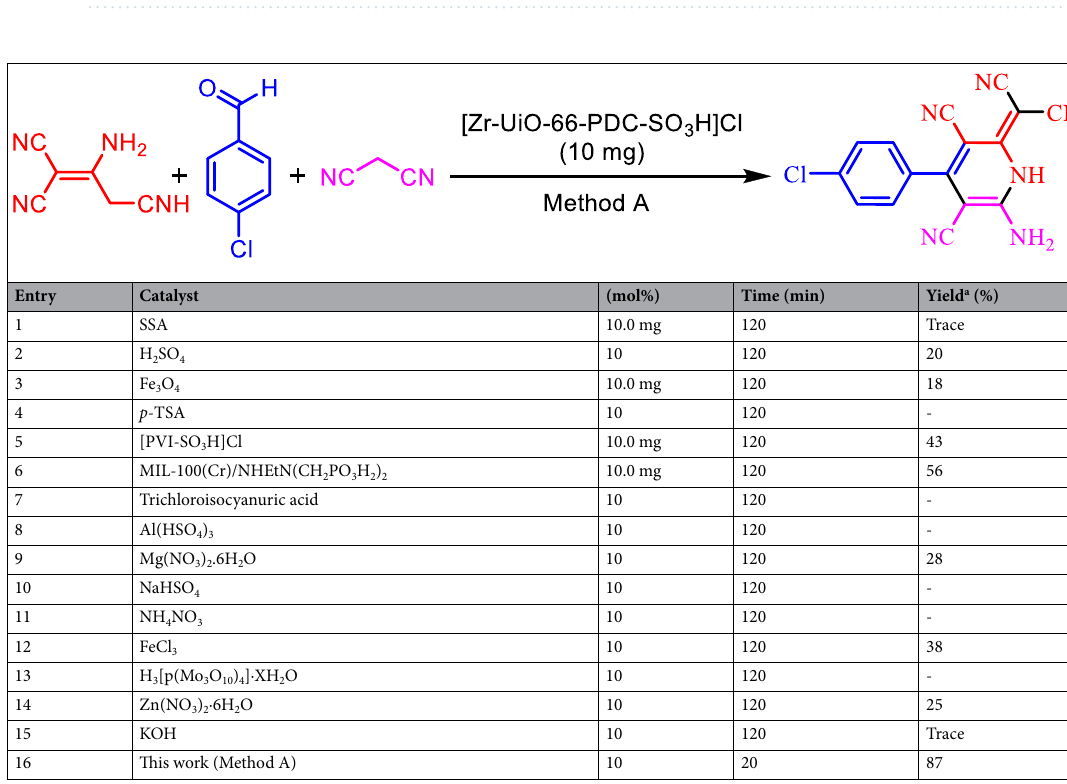
Table 4. Electrochemical synthesis of dicyanomethylene pyridine derivatives in the presence of [Zr-UiO-66- PDC-SO